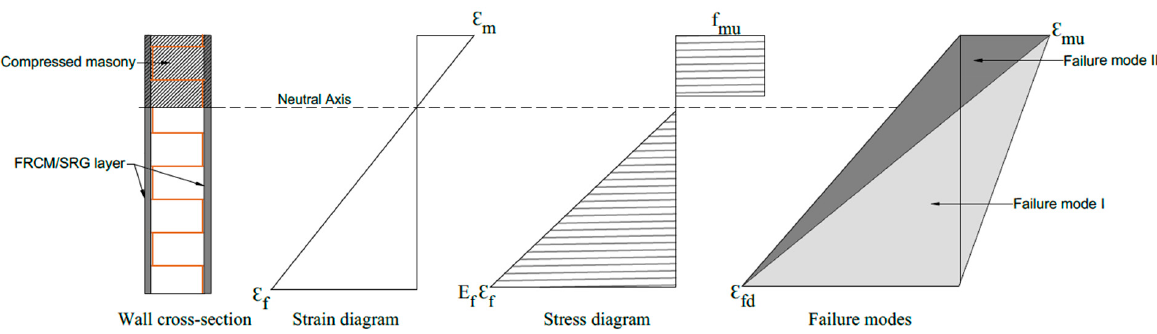
Figure 7. Strut-and-tie-model for the in-plane reinforcement of masonry walls with opening.